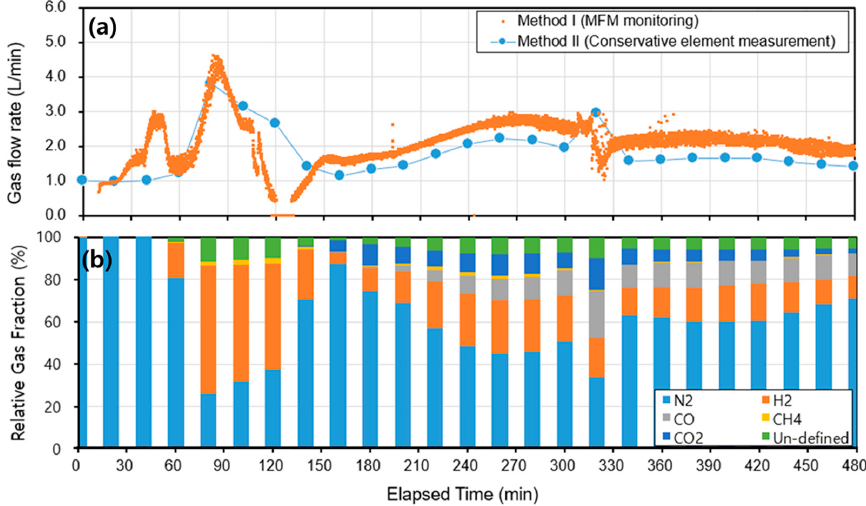
Figure 5. Real-time gas flow rates measured by Methods I and II ( a ) and changes in syngas compositions ( b ).